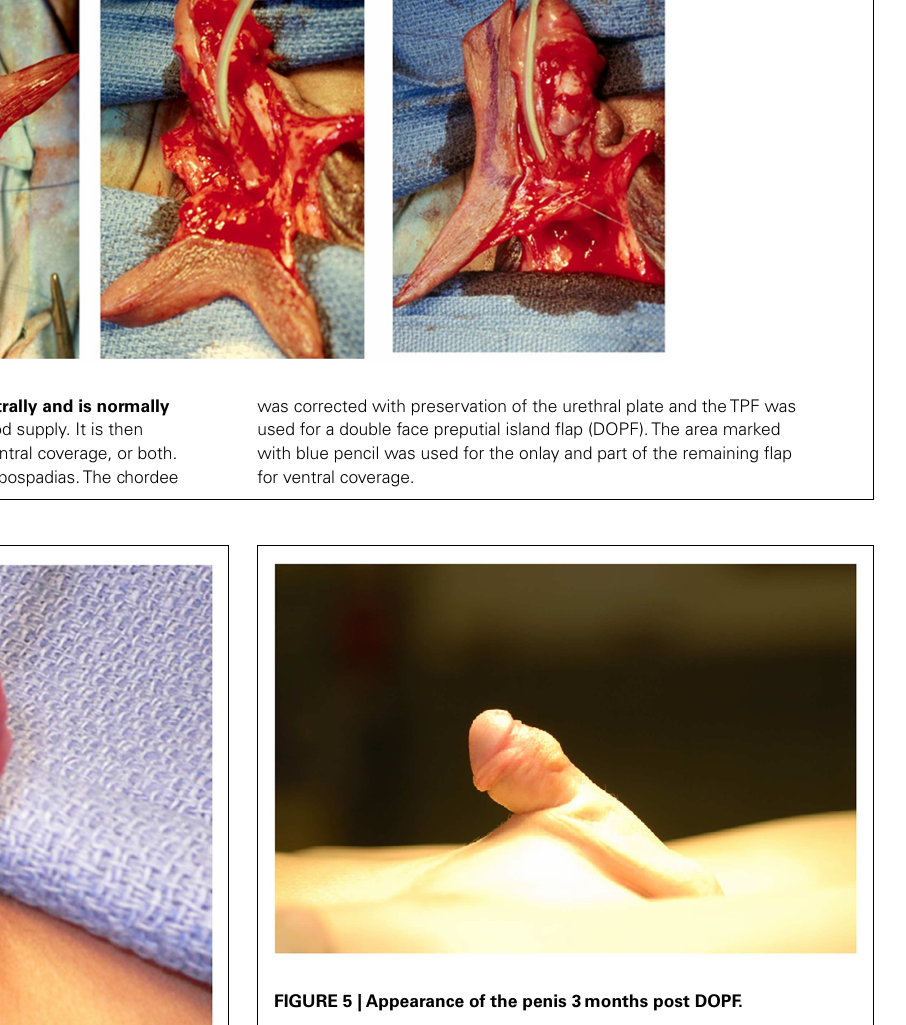
of the urethral plate (Thiersch–Duplay), two had a meatal based flap urethroplasty ( Figure 4 ) (modified Mathieu), one a urethral advancement (Beck), and two epispadias repair ( Figure 6 ). No urethral complications were observed in these patients.